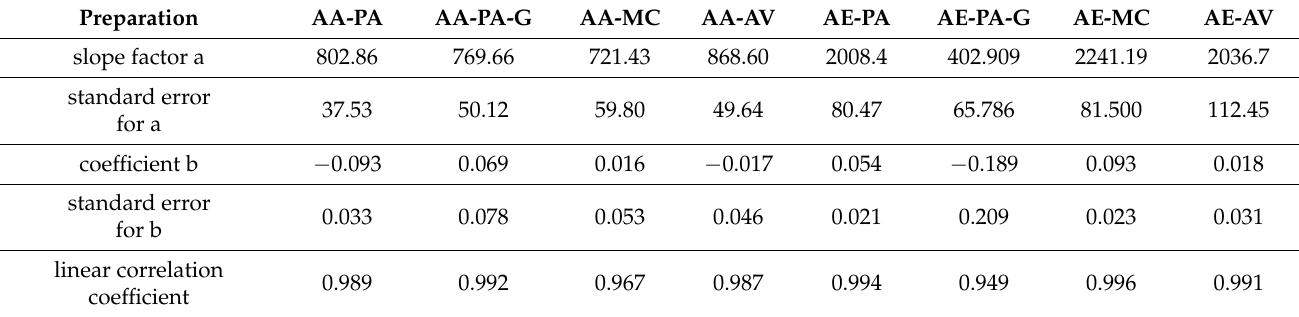
Table 7. Linear correlation parameters for the standard curve y = ax +